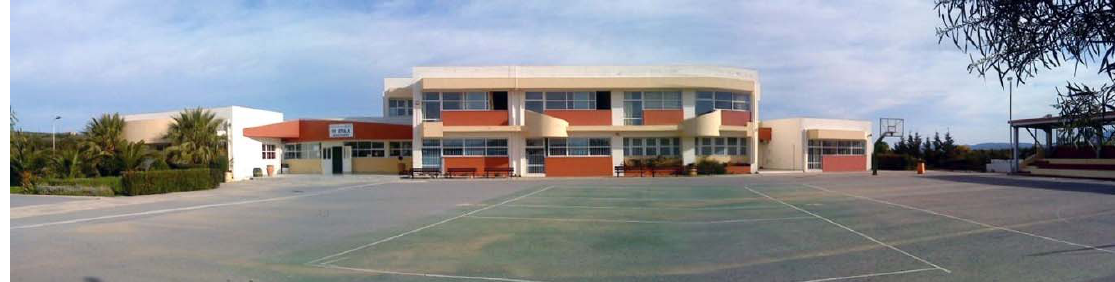
Figure 2. General view of the examined school building.